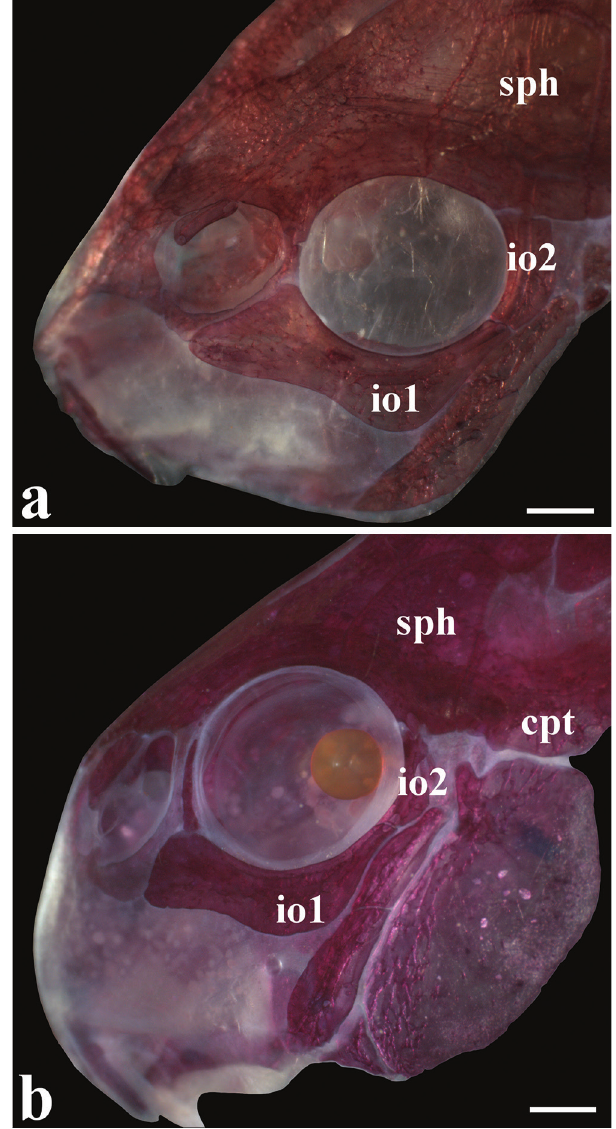
Fig. 3. Lateral view of the head of cleared-and-stained specimens of (a) Corydoras paleatus , UFRGS 1722, 37.6 mm SL, and (b) Corydoras froehlichi , MCP 13388, 40.2 mm SL, paratype. Abbreviations: io1: infraorbital 1, io2: infraorbital 2, sph: sphenotic, cpt: compound pterotic. Scale bar = 1.0 mm.